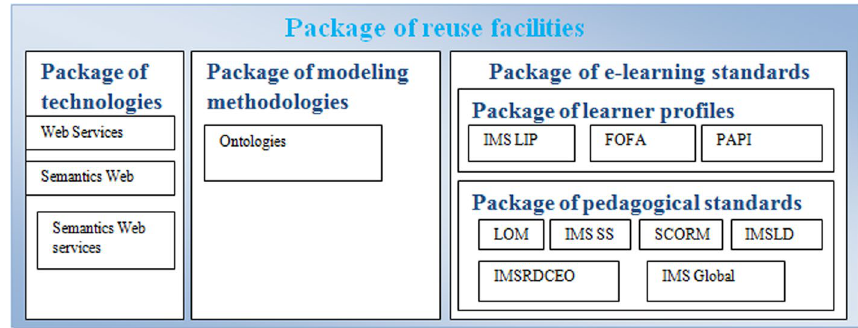
Fig. 7 Package of reuse